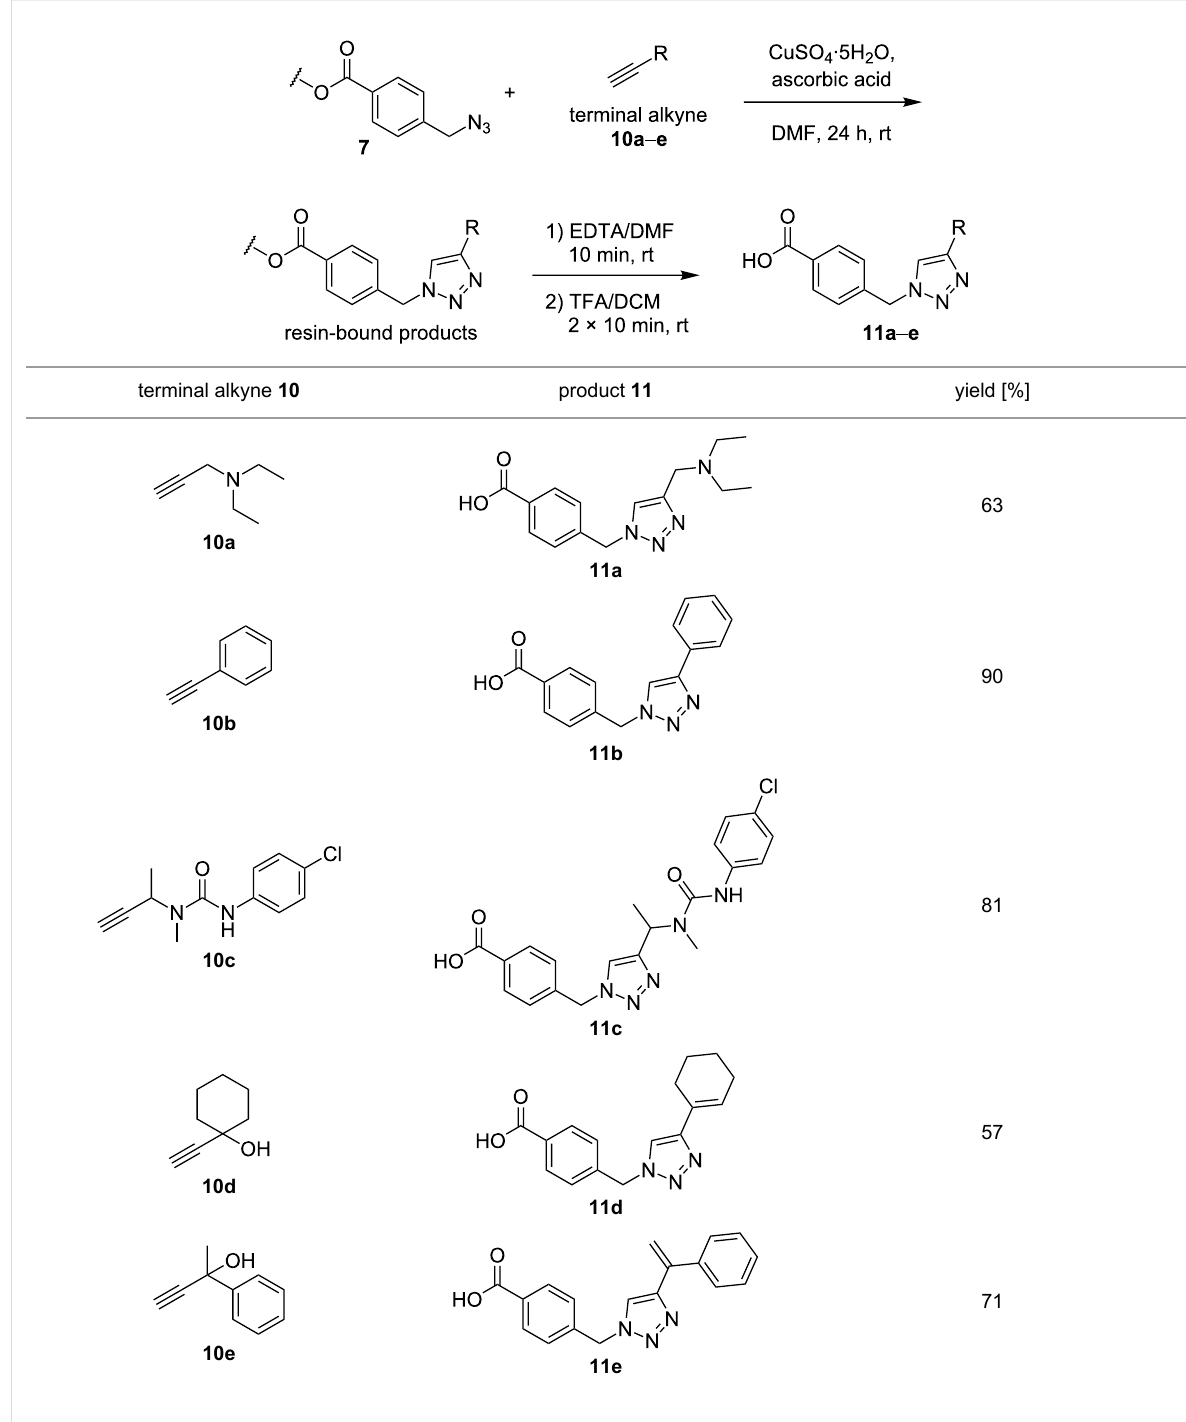
Table 1: Copper-catalyzed [2 + 3] cycloadditions of resin-bound azide 7 with five terminal